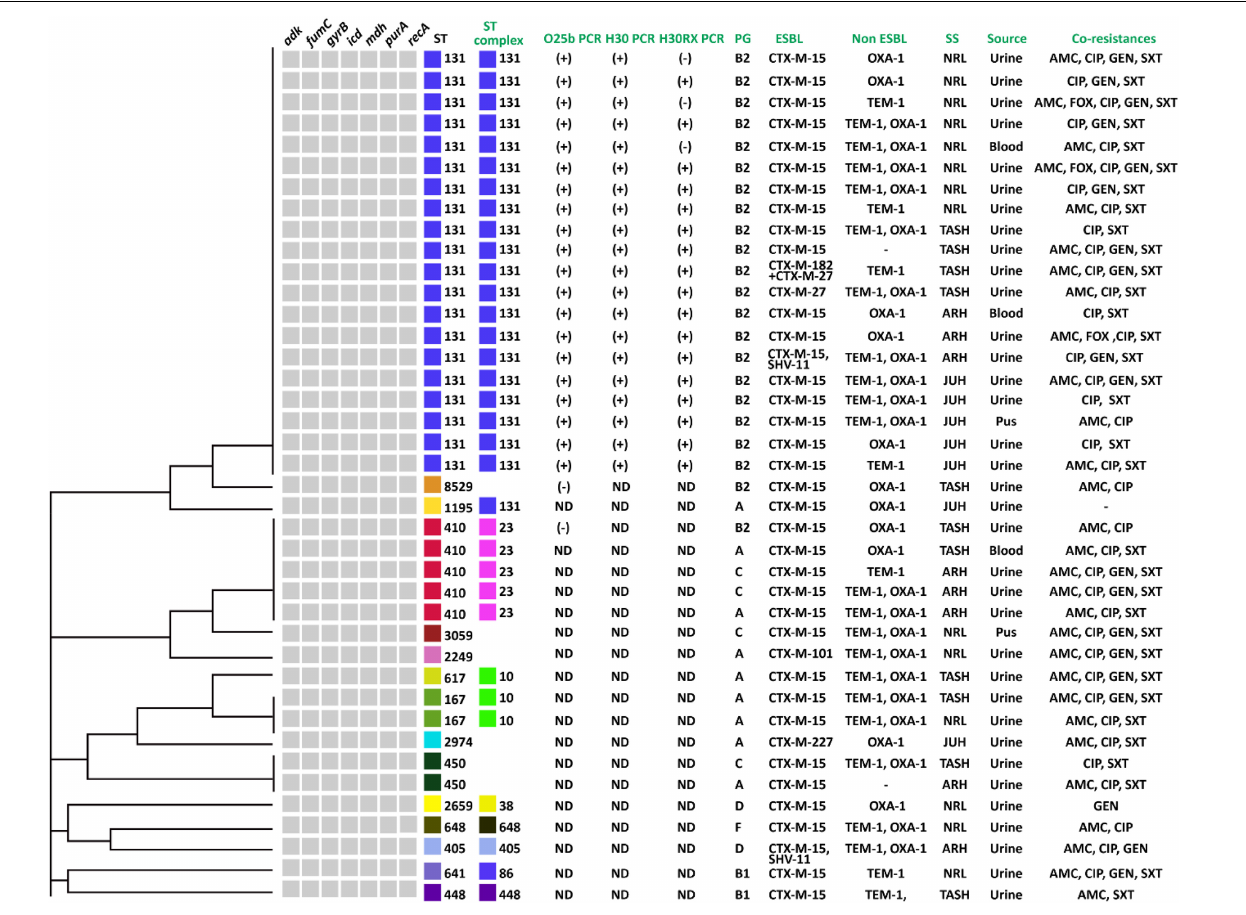
FIGURE 5 | UPGMA dendrogram showing the genetic relationships of STs of 40 ESBL positive E. coli strains from MLST data along with different variables: the ST131 PCR results for O25b, H30, and H30Rx; the phylogenetic groups (PG); type of ESBLs and non-ESBLs; study sites (SS); clinical specimens (sources) and resistance to non-cephalosporin antibiotics and ampicillin (co-resistance). ND, not done, AMC, amoxicillin-clavulanate, FOX, cefoxitine, CIP, ciprofloxacin, GEN, gentamicin, and SXT,